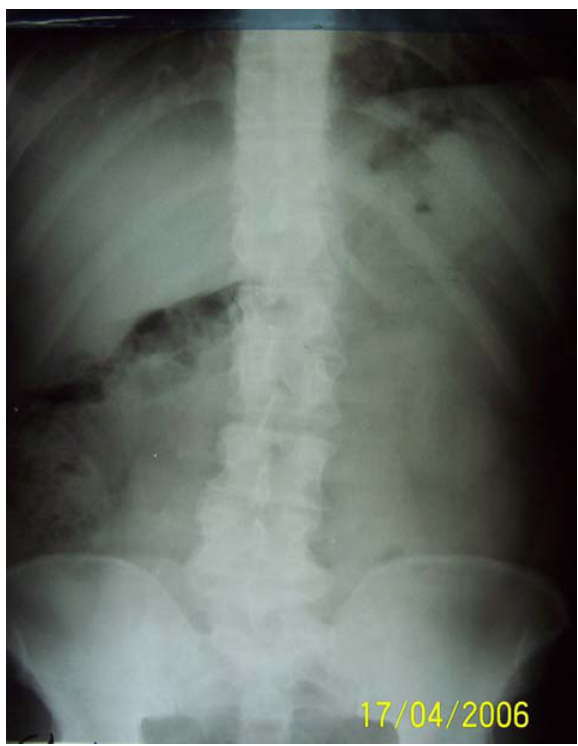
FIGURE 1. KUB (4/17/06). There are not evidence of